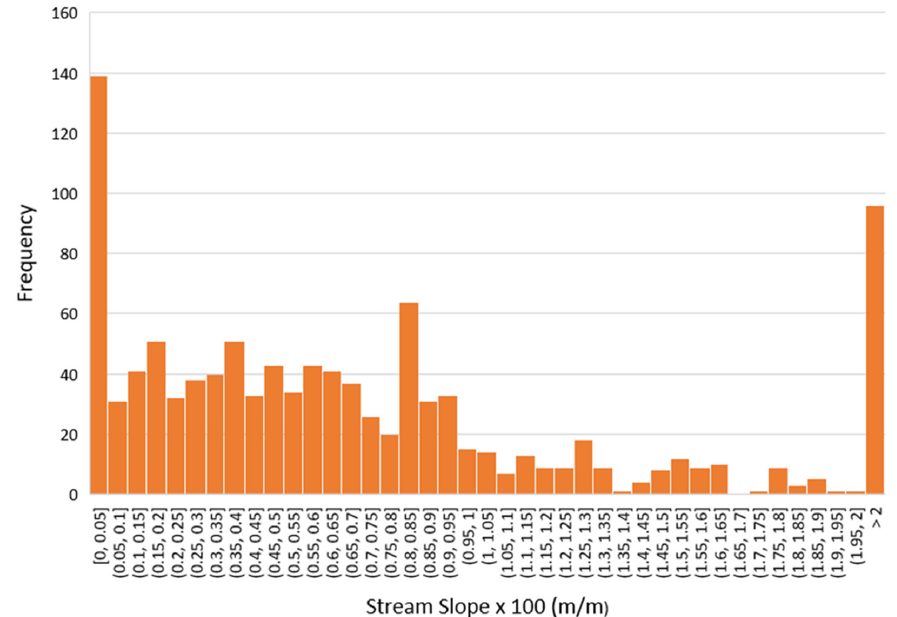
Figure A2. Stream slope at low head dams in Colorado with no fatalities recorded.